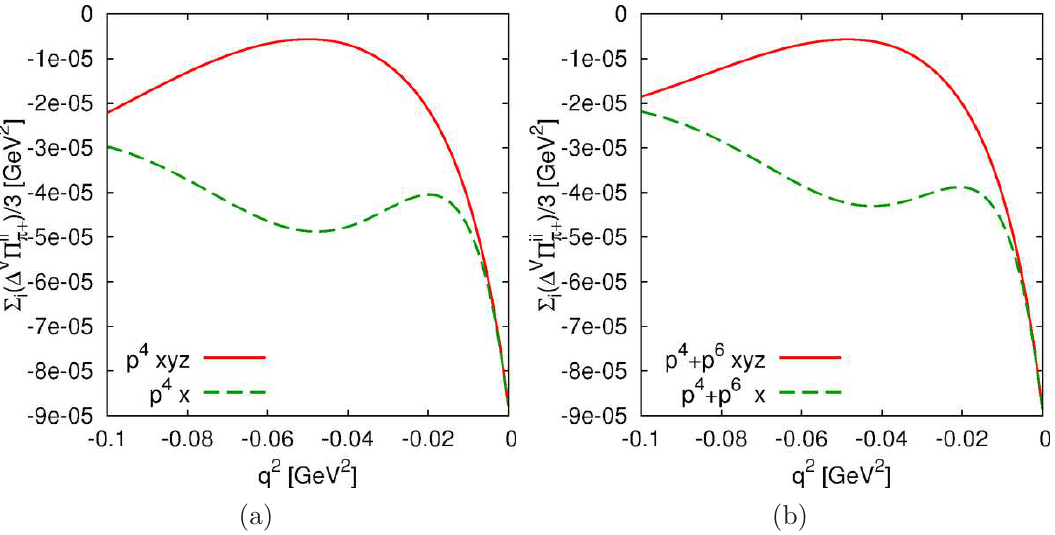
Figure 7 . The finite volume corrections to the spatial average as defined in (7.6). xyz is the spatially symmetric twisting and x twisting only in the x -direction. (a) p 4 (b) Sum of p 4 and p 6